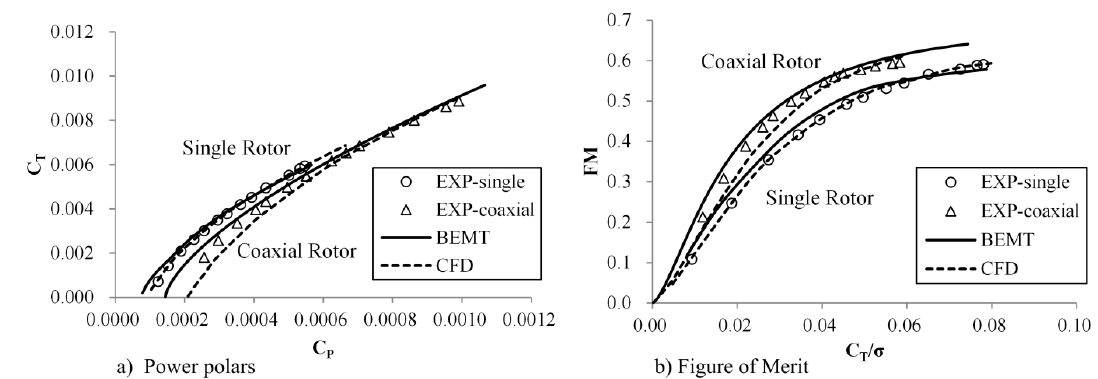
Figure 4. Performance of rotor 2: a comparison of results by the current blade element momentum theory (BEMT), computational fluid dynamics (CFD) [19], and experiments [4] (marked as EXP).